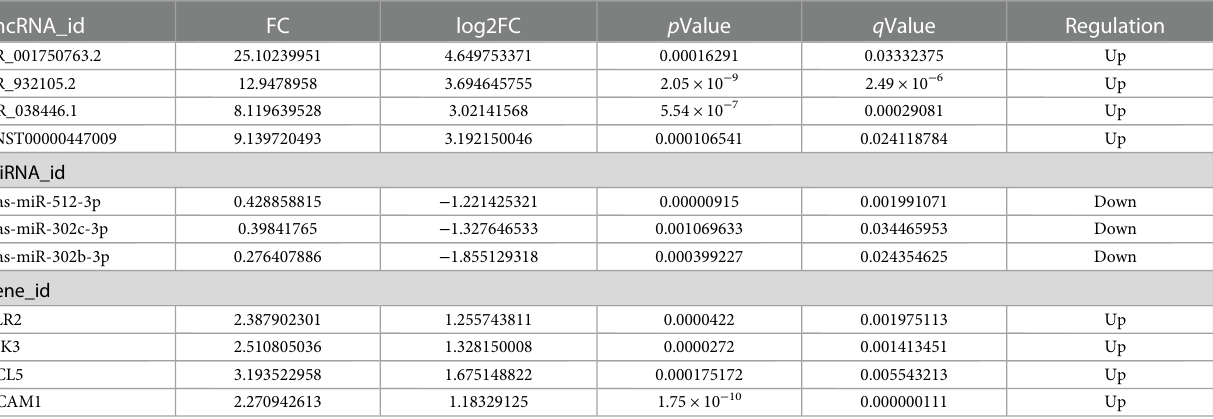
TABLE 4 Selected DERNAs in LAA tissues.